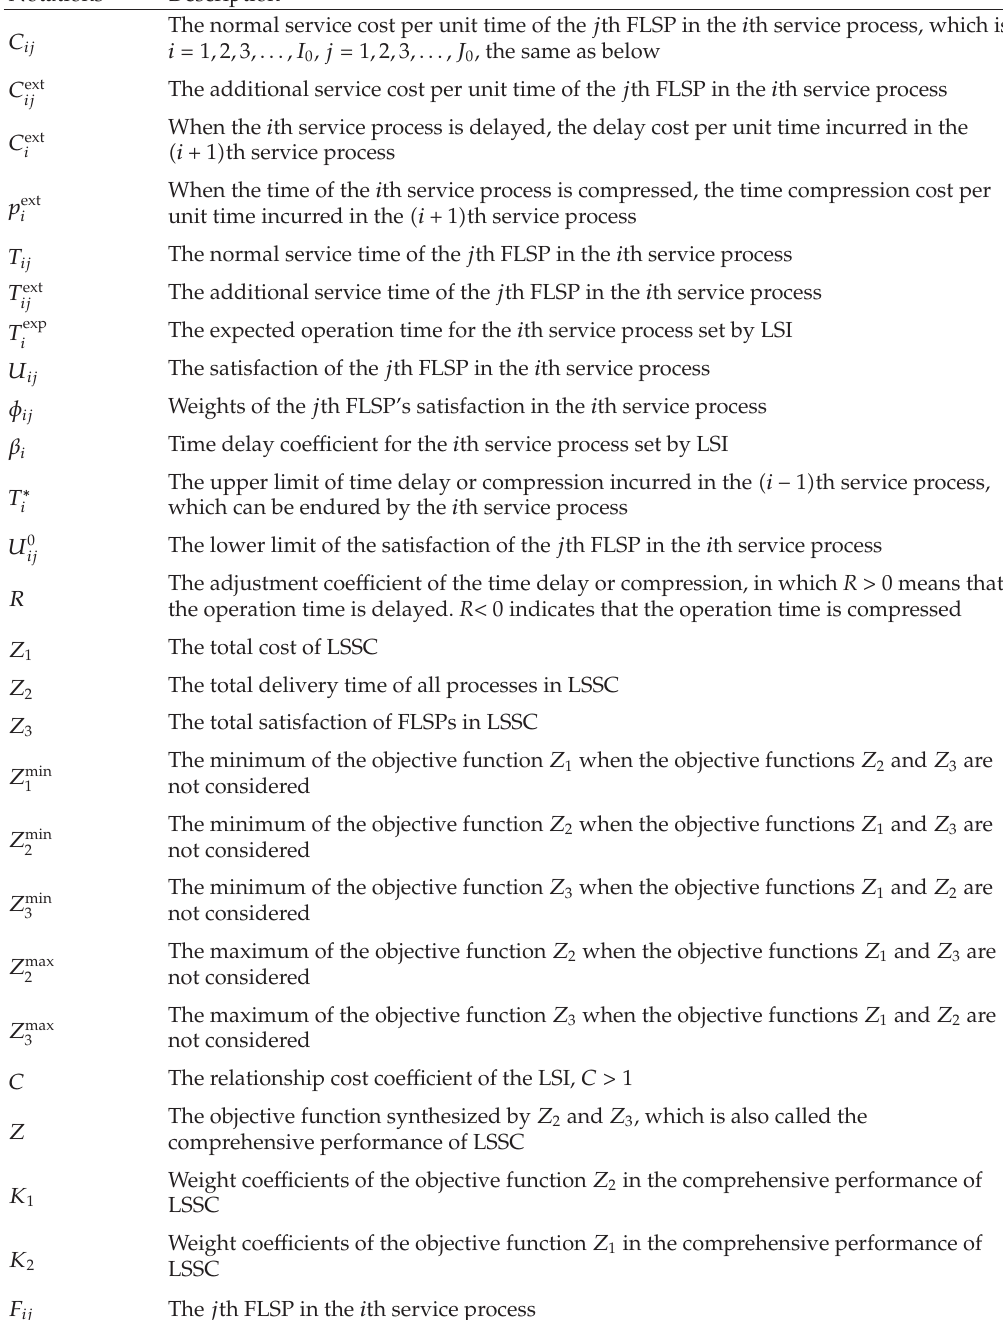
Table 1: Notations for the